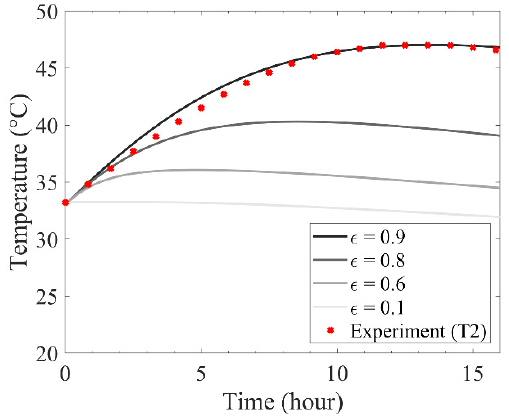
Figure 6. Effects of bed void fraction on the temperature at the center of a closed container. (Condition: T 0 = 33 °C, T ambient = 25 °C, H container = 1 m).